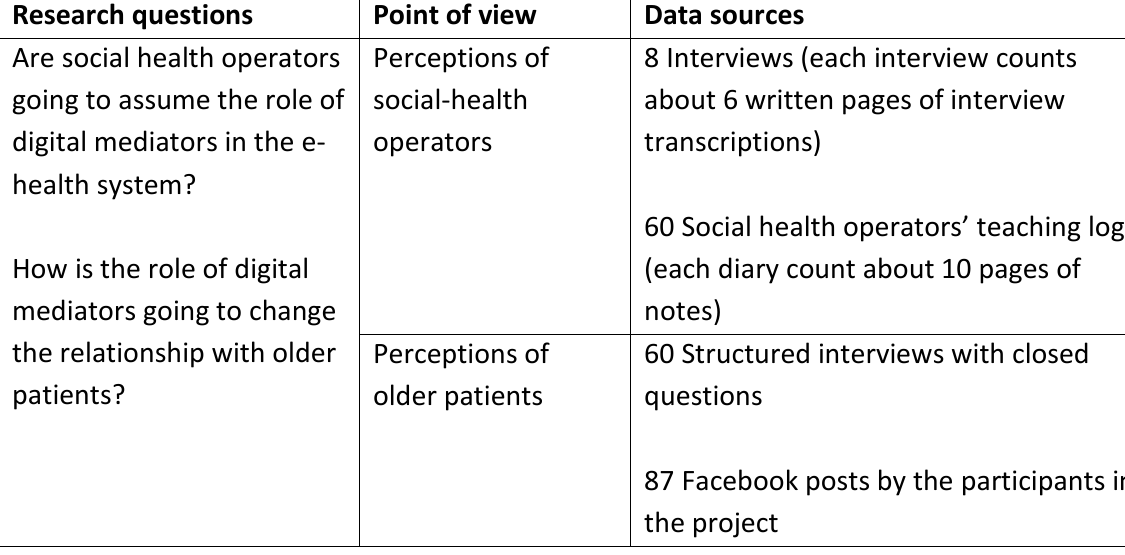
Table 2. Research questions, point of view and data